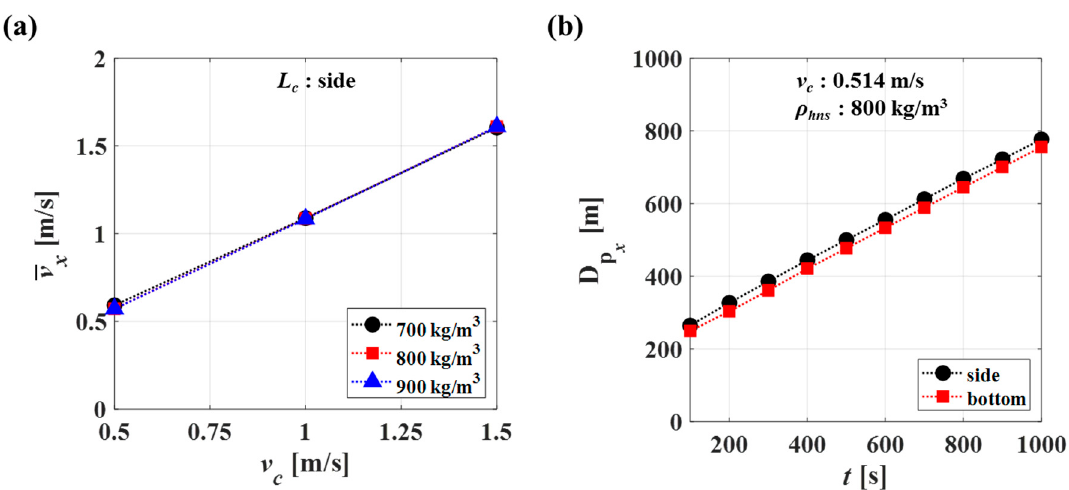
Figure 5. ( a ) Streamwise propagation velocity of the HNS for the input variables and ( b ) max propagation distance in the streamwise direction between the case of the side crack and bottom crack.